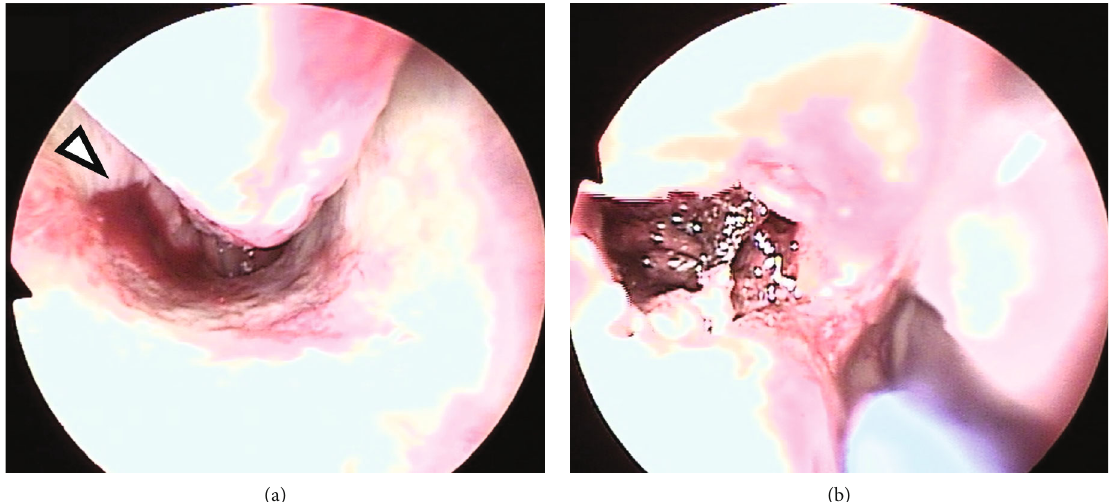
Figure 3: Endoscopic image ((a) at the time of bleeding, (b) at the time of hemostasis). (a) A laceration is found on the side wall of the right inferior nasal passage, and arterial bleeding is observed (arrowhead). (a) Hemostasis is achieved by cauterization of the nasal